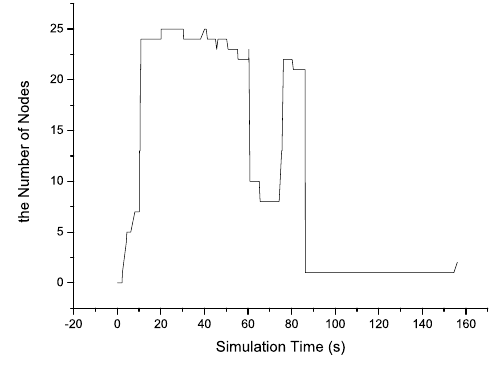
Fig.8. The number of destination nodes of the routing table in node n 25